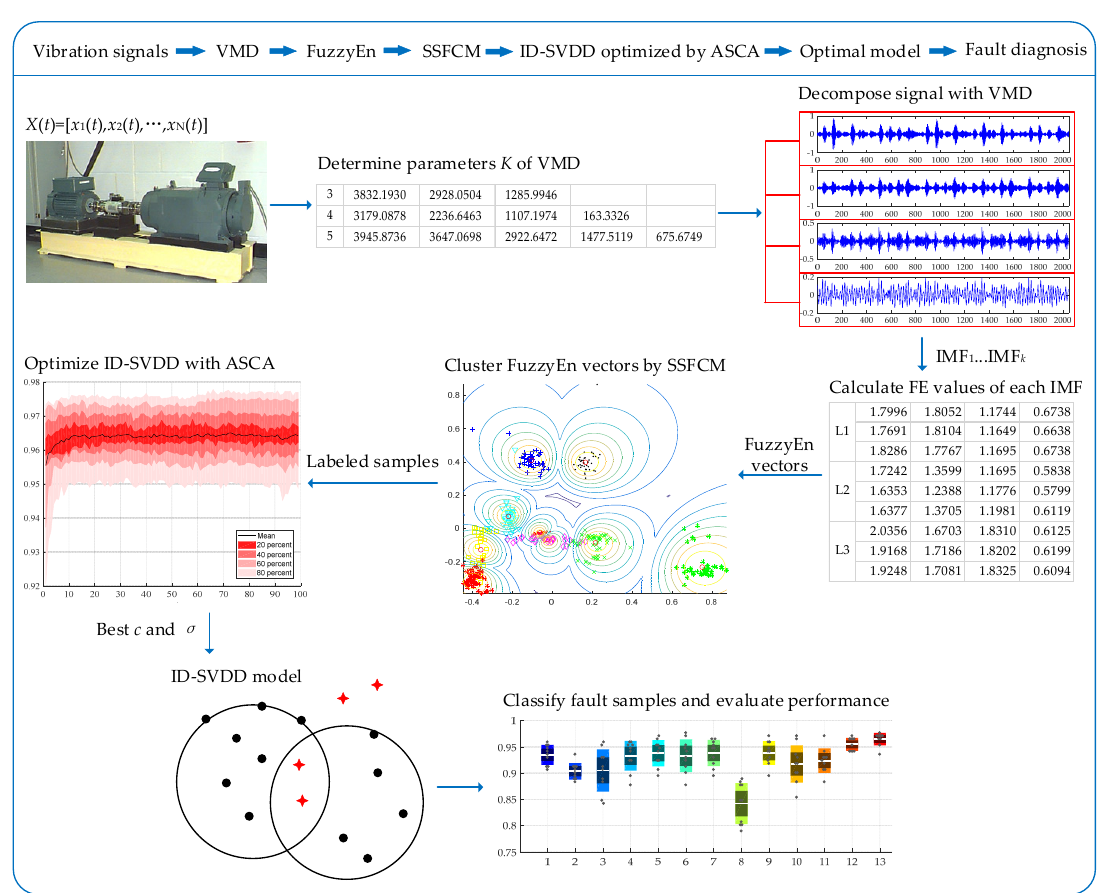
Figure 4. The flowchart of the proposed fault diagnosis method.